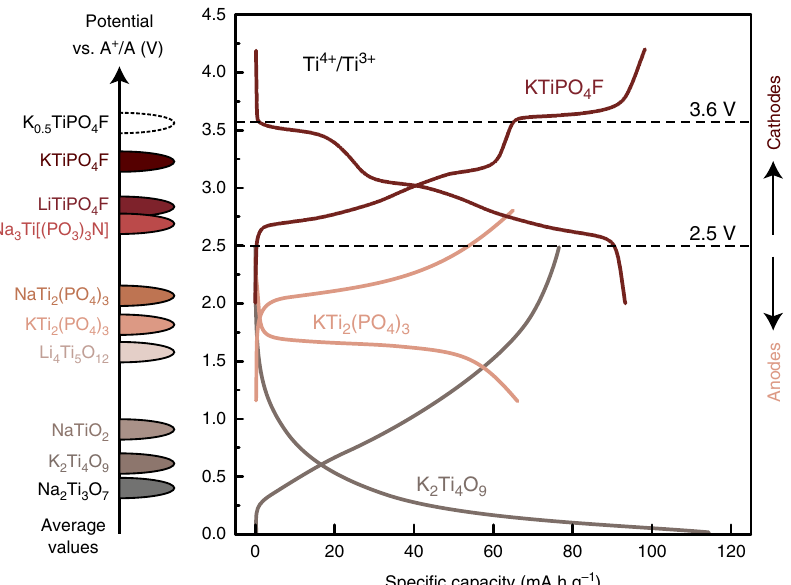
Fig. 5 Comparison of the average operating potentials of Ti-based electrode materials and charge/discharge curves for several representatives. Dashed line at 2.5 V shows a tentative border between cathode (above) and anode (below) materials. Dashed line at 3.6 V designates the average potential of the K 0.5 TiPO 4 F/TiPO 4 F